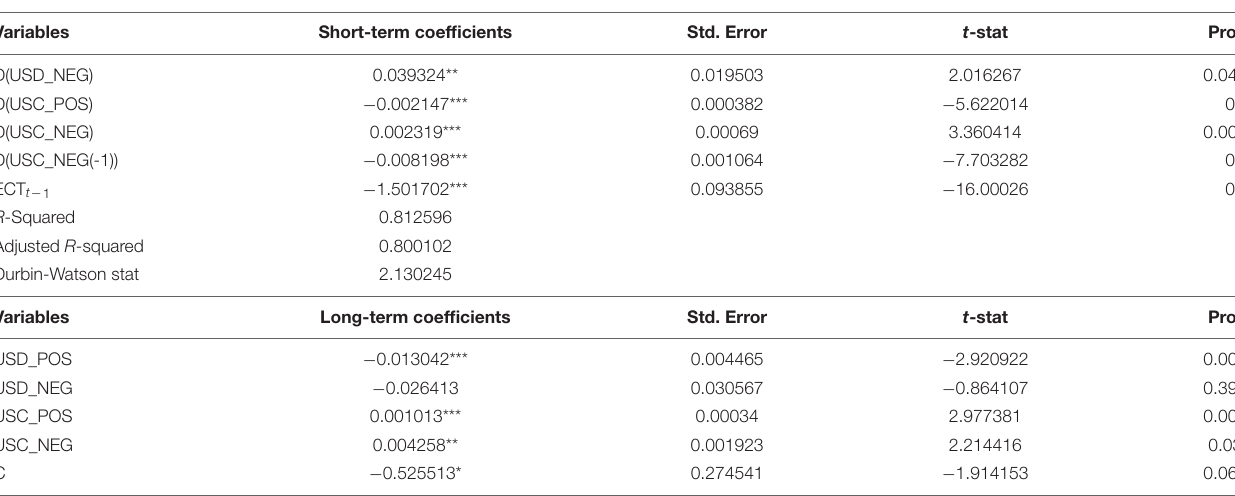
TABLE 6 | Asymmetric parameters of